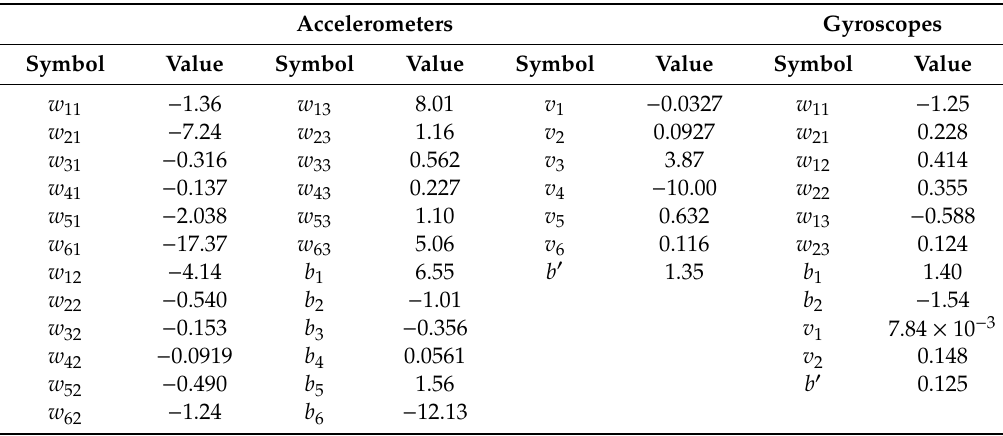
Table 8. The calibration results of x-axis IMU based on method